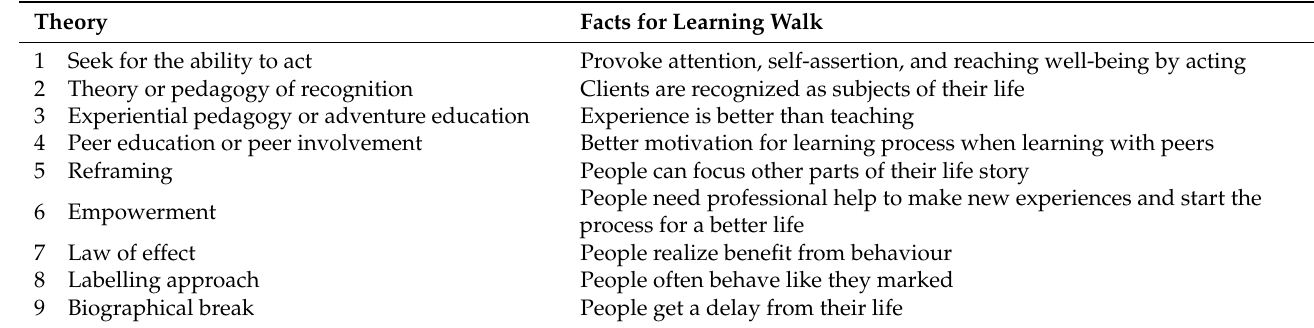
Table 1. Theories and their facts relating the learning